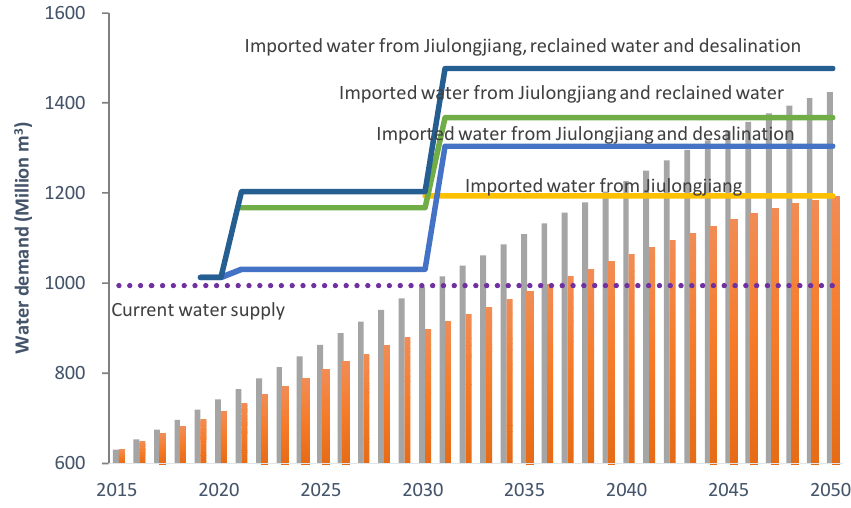
Figure 9. Projected future Xiamen City water supplies and demand considering local resources and trans-basin water diversion. Note: PLS is the acronym for planning scenario; DWS is the acronym for double water-saving scenario.